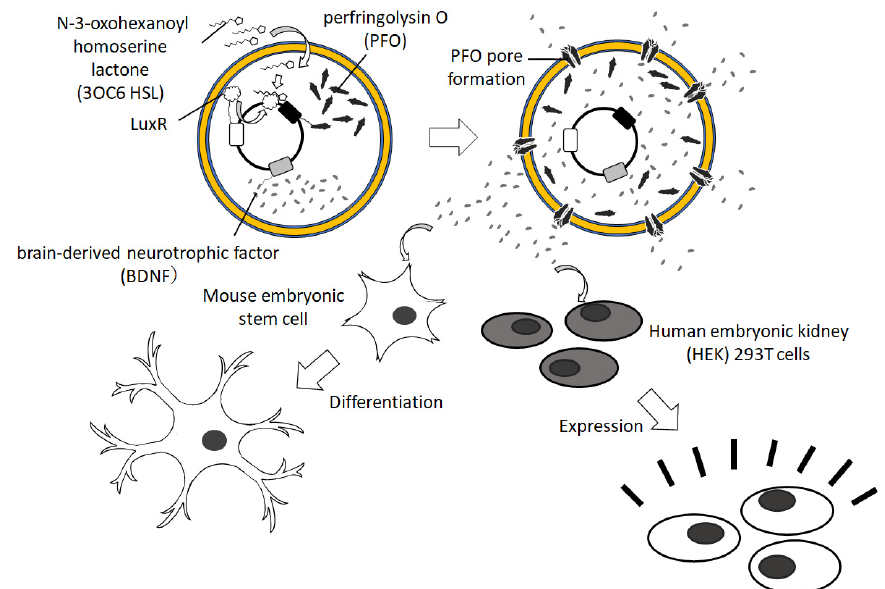
Figure 6. Schematic illustration of arti fi cial cells driving neural di ff erentiation and cell transfor- mation.